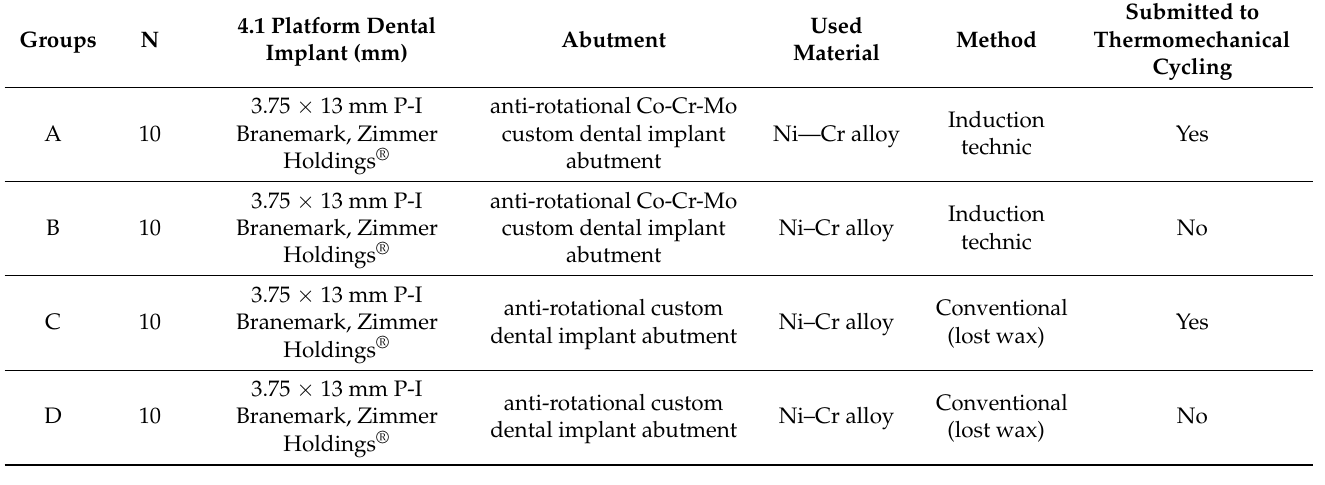
Table 1. Experimental groups.